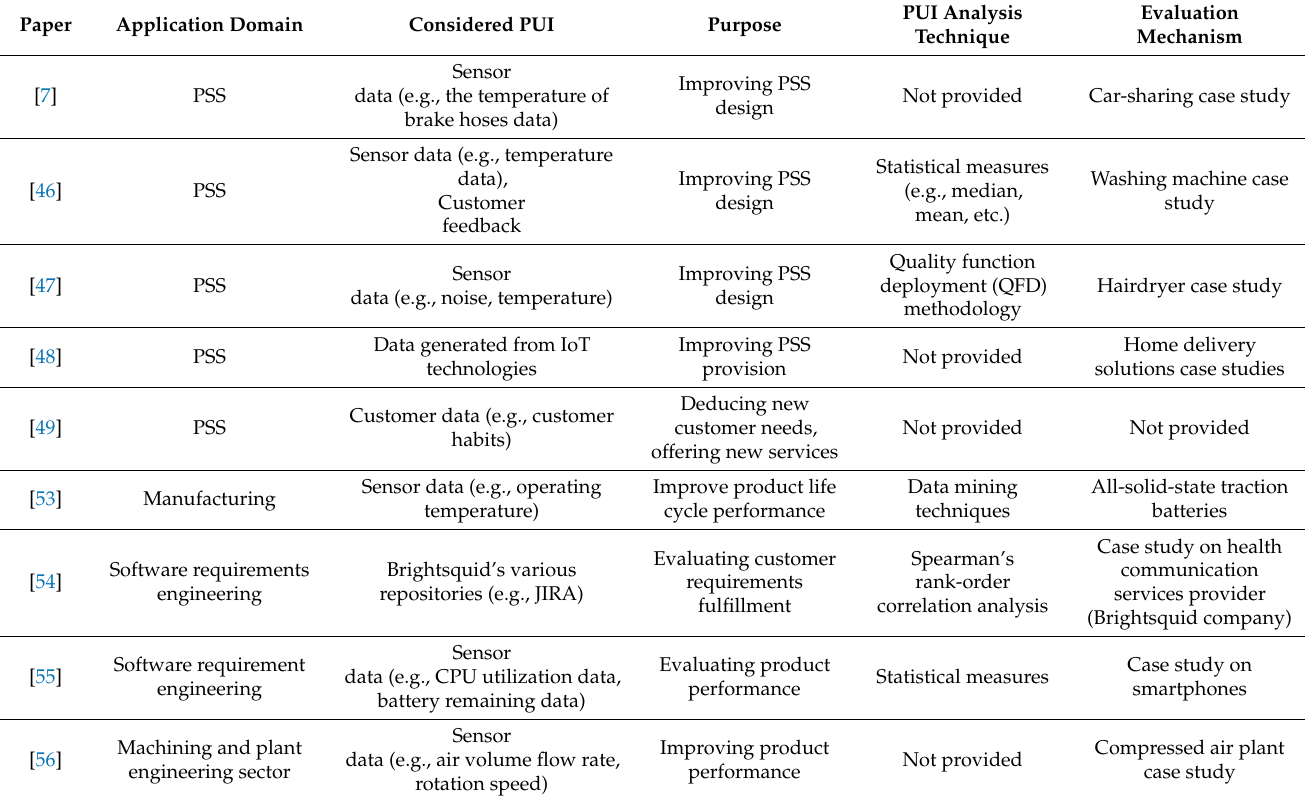
Table 2. Related work efforts for exploiting product usage information